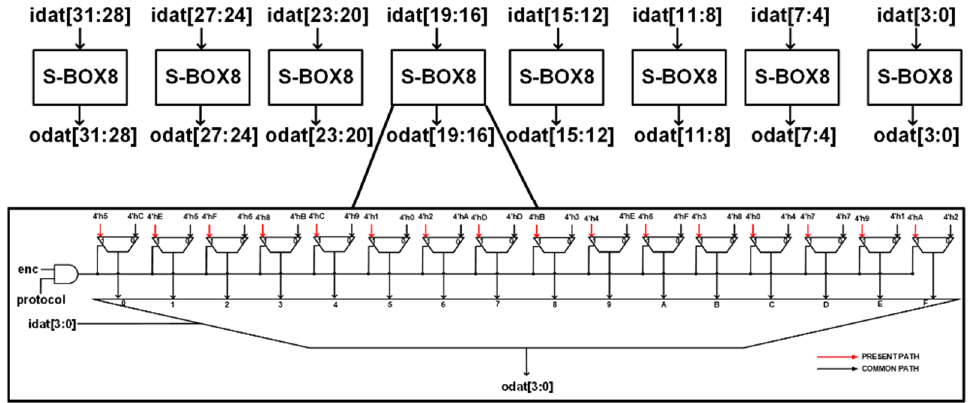
Figure 14. Proposed hardware architecture for 32-bit Unified S-BOX.